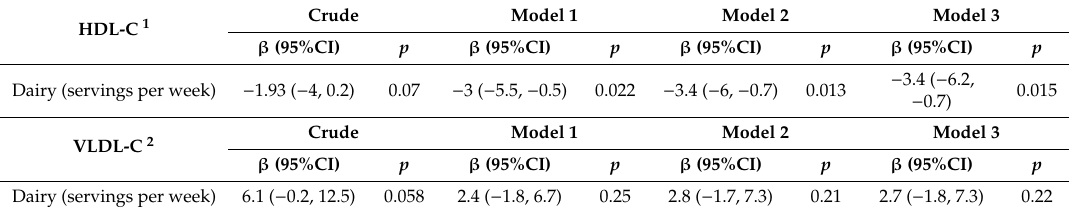
Table 3. Association between serum HDL-C and VLDL-C, and dairy